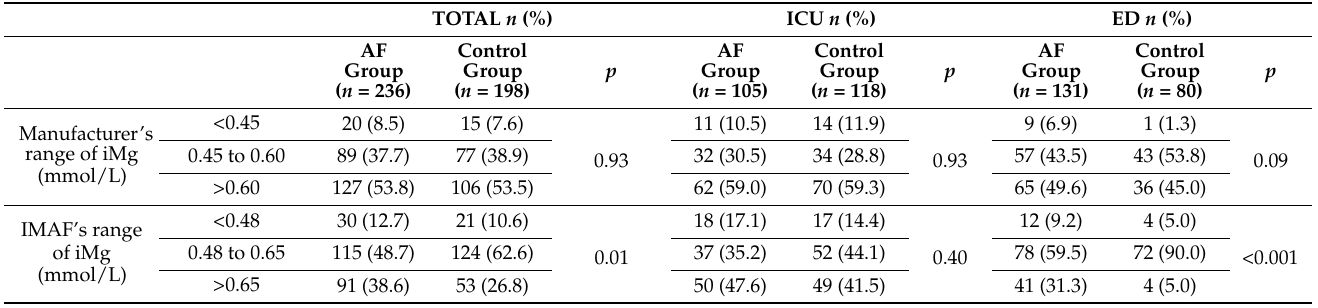
Table 3. Repartition of hypo, normo, and hyper iMg among 236 patients with de novo AF and